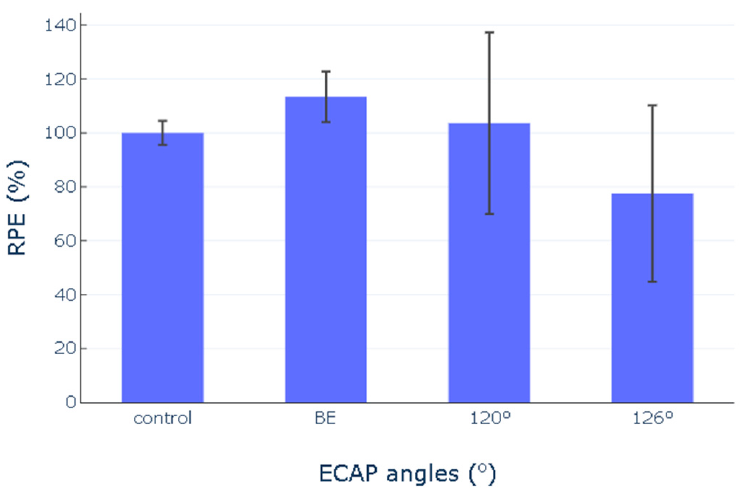
Figure 7. Cytotoxicity evalution of BE and ECAPed SS316L by the direct contact method (mean ± sd). No significant difference was observed between the control and three different samples.